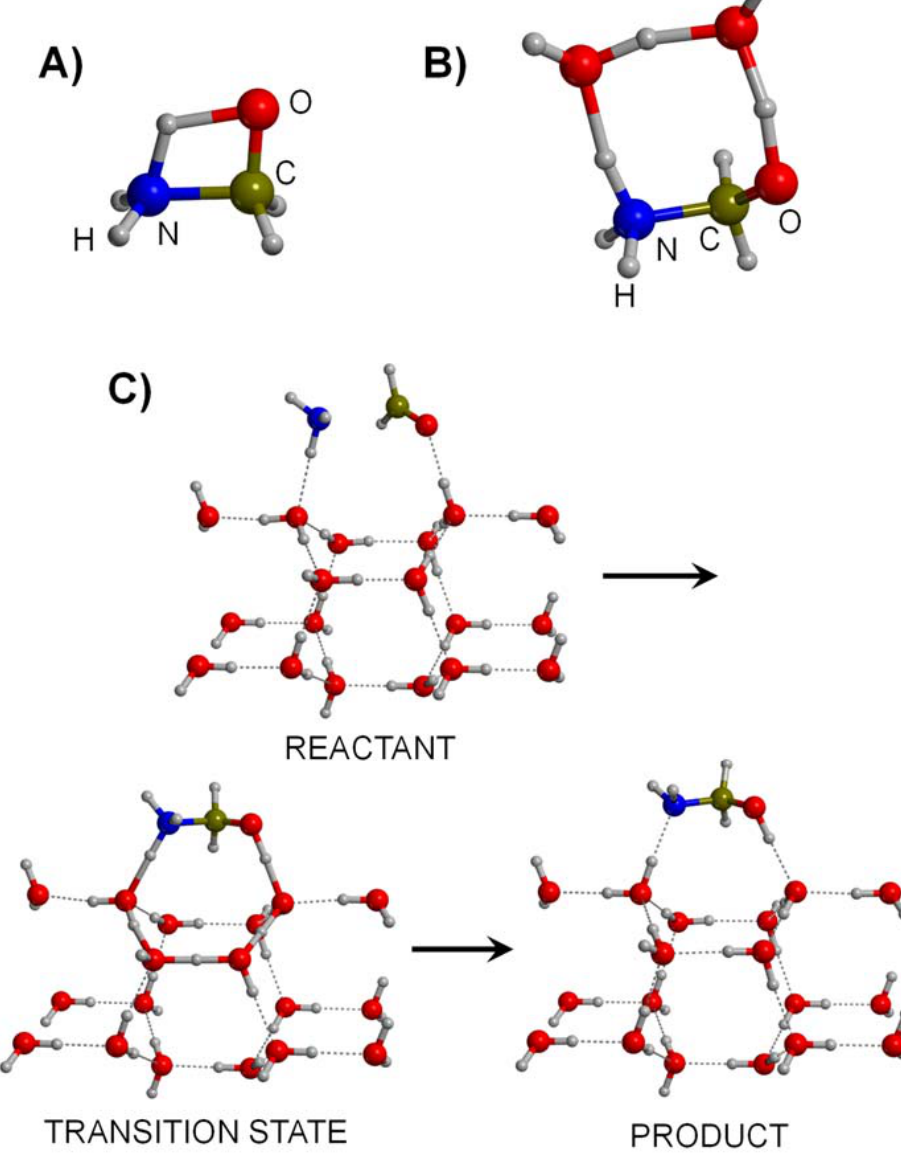
Figure 1. ( A ) Transition state structure of the reaction of NH 3 + H 2 CO → NH 2 CH 2 OH (aminomethanol formation) corresponding to the first step of the Strecker synthesis under strict gas ‐ phase conditions. ( B ) The same transition state structure as ( A ) in which two water molecules participate in the proton transfer, giving rise to a water ‐ assisted proton transfer mechanism. ( C ) Stationary points of the aminomethanol formation on a water ice cluster model. The transition state adopts a water ‐ assisted proton transfer mechanism involving four water molecules. Adapted from Ref. [140].